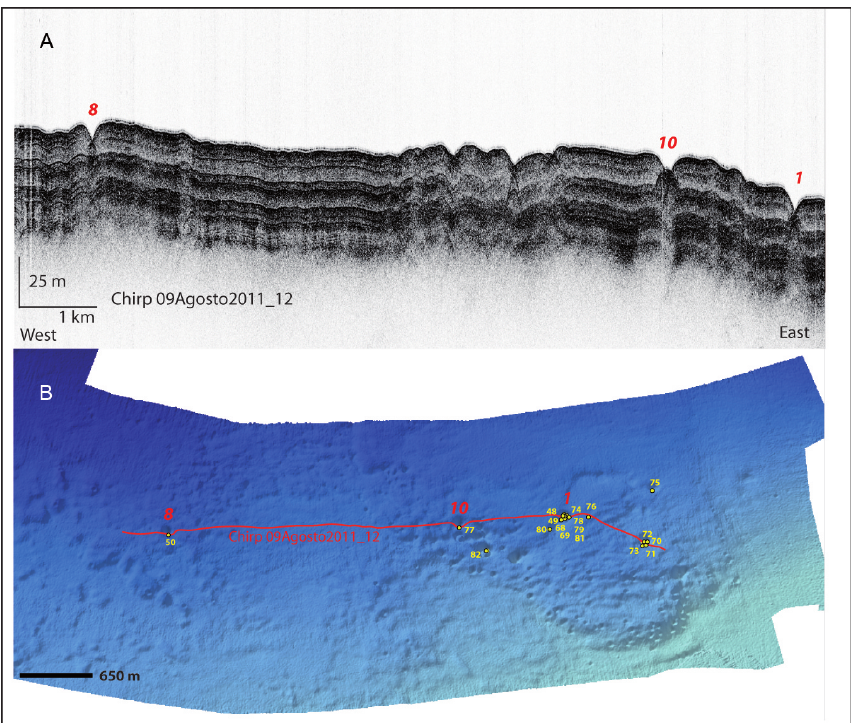
Fig. 5. (A) Chirp profile showing the subsurface stratigraphy of the pockmark area; (B) 3-D perspective view of the DTM shows the location of the chirp profile and the sample locations (yellow); red numbers are